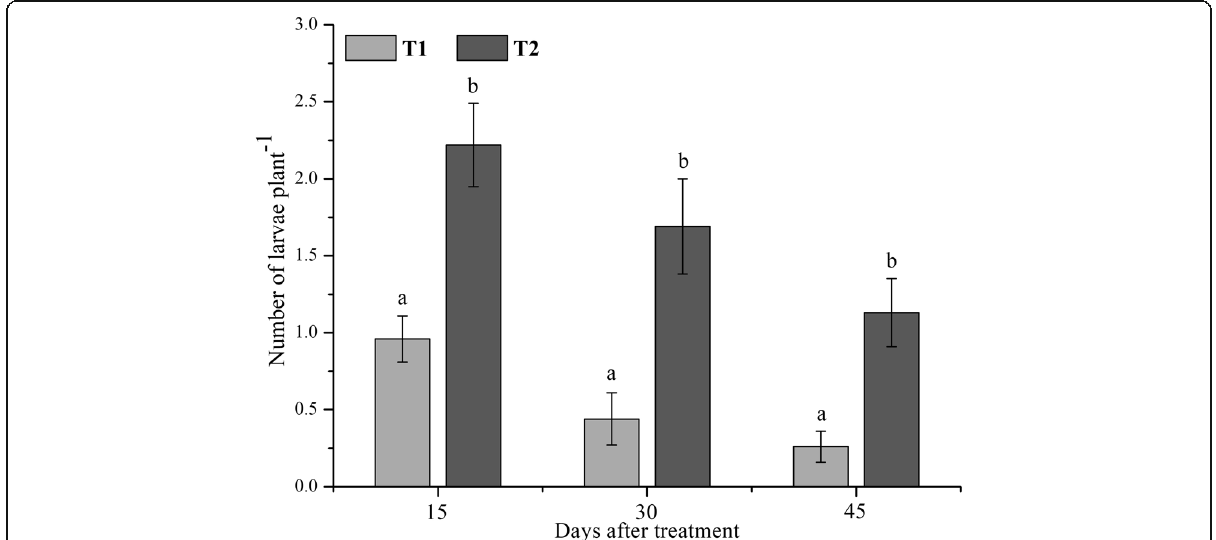
Fig. 1 Effect of biocontrol-based IPM and farmers ’ practice on larval reduction of DBM in cabbage at 15, 30, and 45 days after treatment. Different letters on the top of error bars indicate statistically different values for different treatments using Tukey ’ s test ( P < 0.05). Bars = standard error, T1 = biocontrol-based IPM, T2 = farmers ’